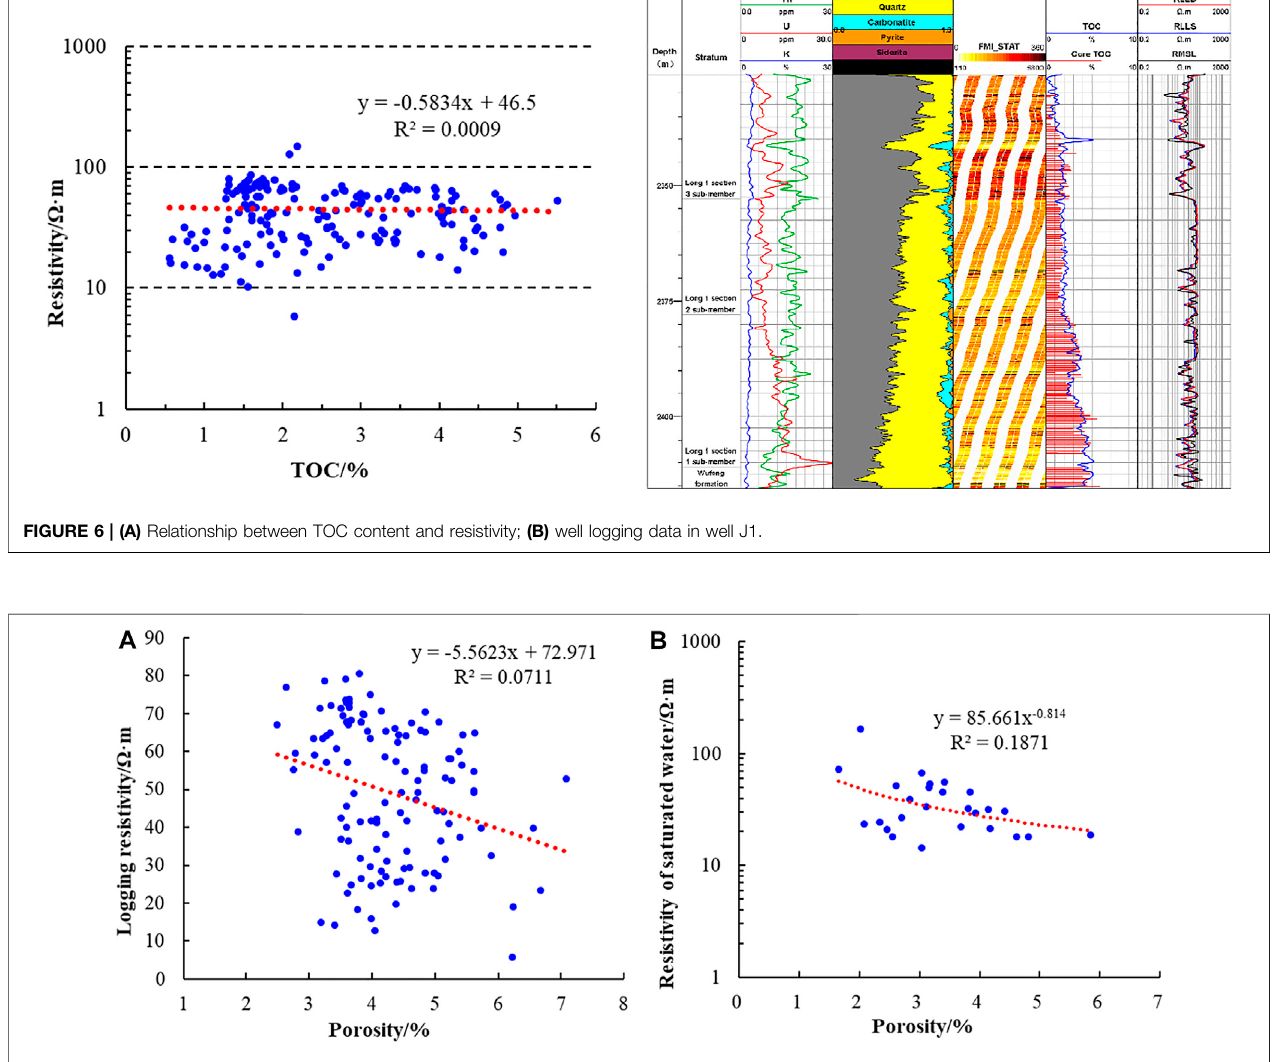
FIGURE 7 | Relationship between porosity and resistivity: (A) porosity and logging resistivity (RLLD); (B) porosity and resistivity of shale in a water-saturated state.